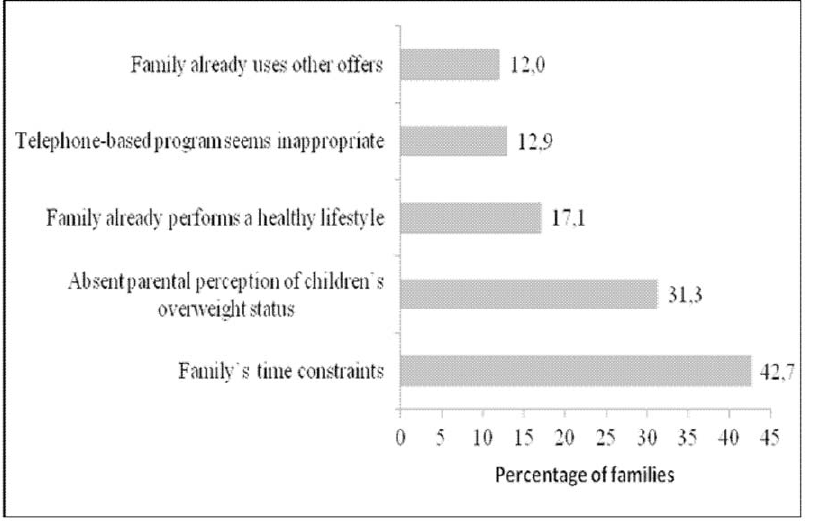
Figure 1. Main reasons for nonparticipation given by parents from a defined list. Multiple answers were possible.